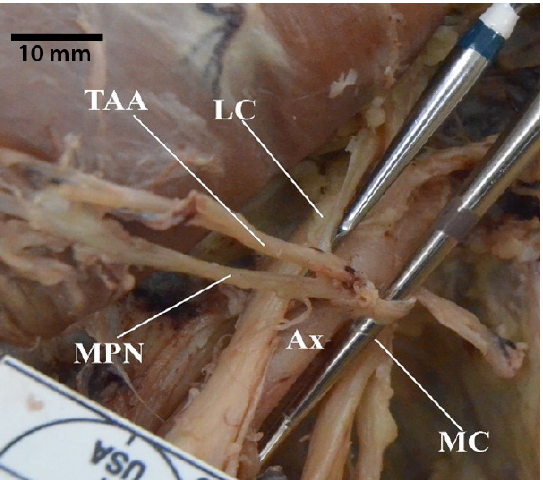
Figure 9. Photograph showing the medial pectoral nerve receiving contributions from both medial and lateral cords with the pectoral branch of thoracoacromial artery travelling in between the two contributions. Abbreviations: Ax = axillary artery; LC = lateral cord; MC = medial cord; MPN = medial pectoral nerve; TAA = thoracoacromial artery (pectoral branch).